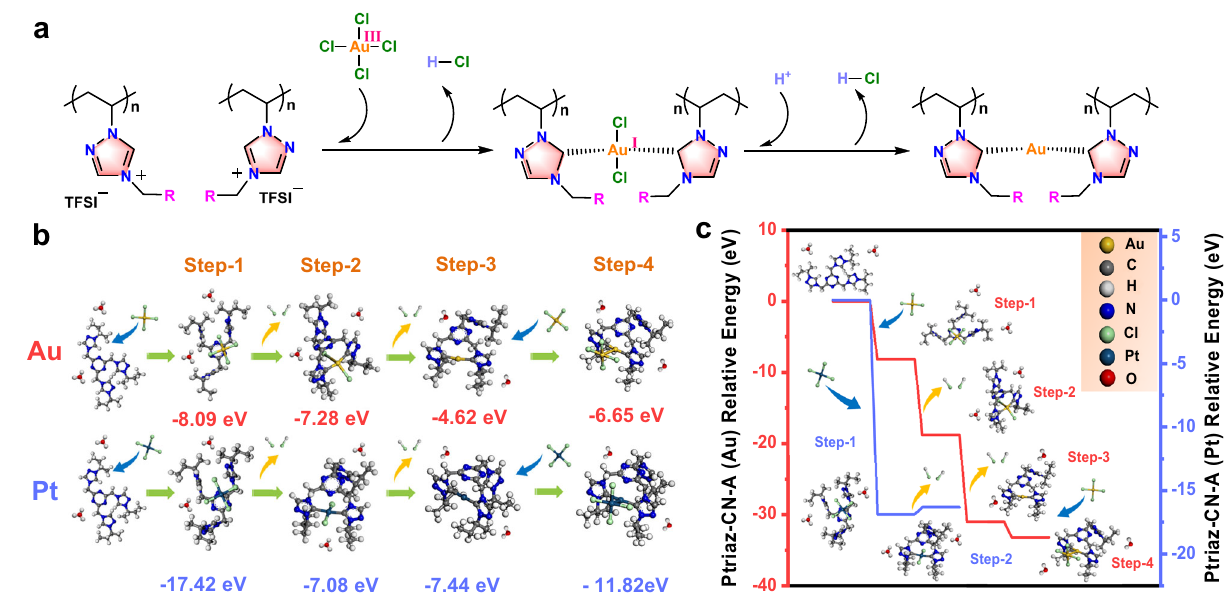
Fig. 5 | DFT calculation analysis. a Proposed mechanism of Au 3+ adsorption- reduction on Ptriaz-CN-A. b Adsorption energy ( E ads ) in step 1 and binding energy ( E bind )insequentialstep2tostep4ofAuCl 4 − andPtCl 4 2 − withamodelunitofPtriaz-